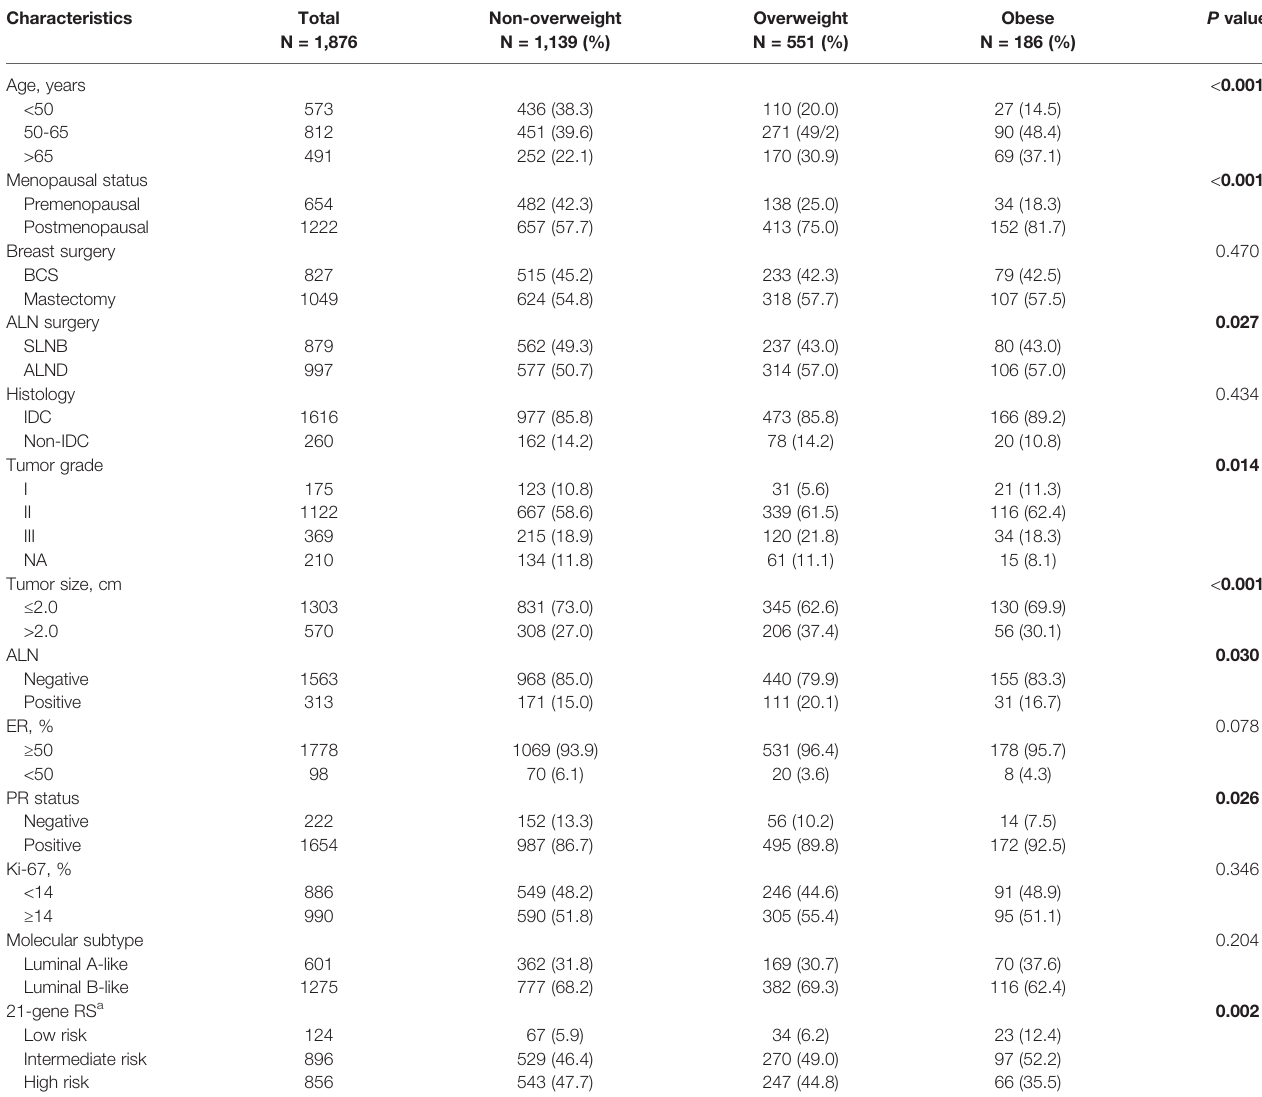
TABLE 1 | Baseline characteristics of study participants (N = 1,876). Characteristics Total Non-overweight Overweight